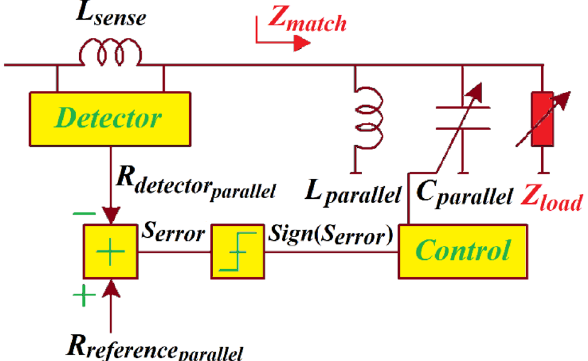
Figure 8. Parallel LC -network to control the real-part of the matched impedance R match